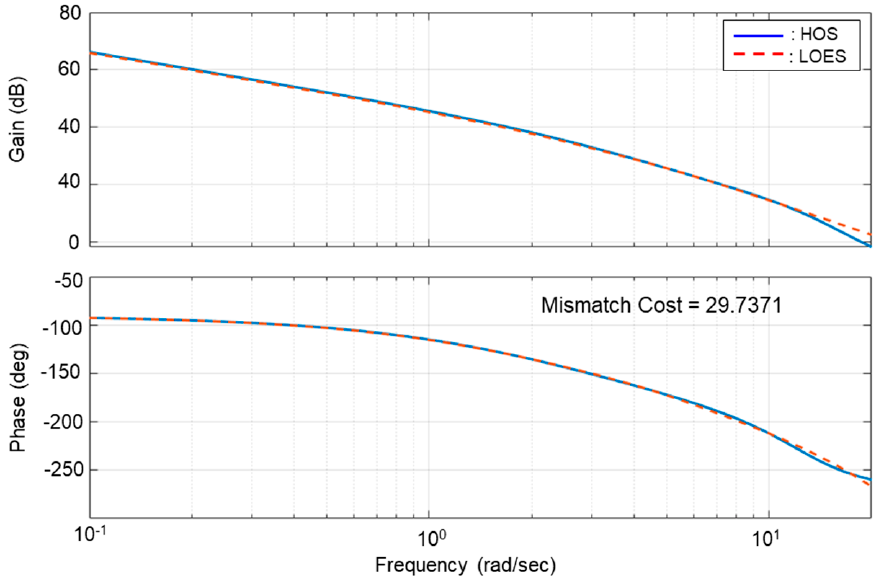
Figure 6. Gain and phase plot—HOS vs. LOES (M0.8, 30 K, UA, 1 g, K aug = 1.0). The bandwidth criterion [11] is a handling quality criterion at the high-frequency band in which the phase margin is at least 45 ◦ and the gain margin is at least 6 dB, also providing the criteria for time delay resulting from phase delay in the frequency domain. Figure 7 shows the analysis results of bandwidth for roll and sideslip in flight conditions for each control method. For all the control methods, the change of flying qualities in bandwidth for both roll and sideslip is small and negligible, and the time delay slightly increases as K aug increases. Overall, the bandwidth is less affected regardless of control method type, satisfying flying quality level 1.